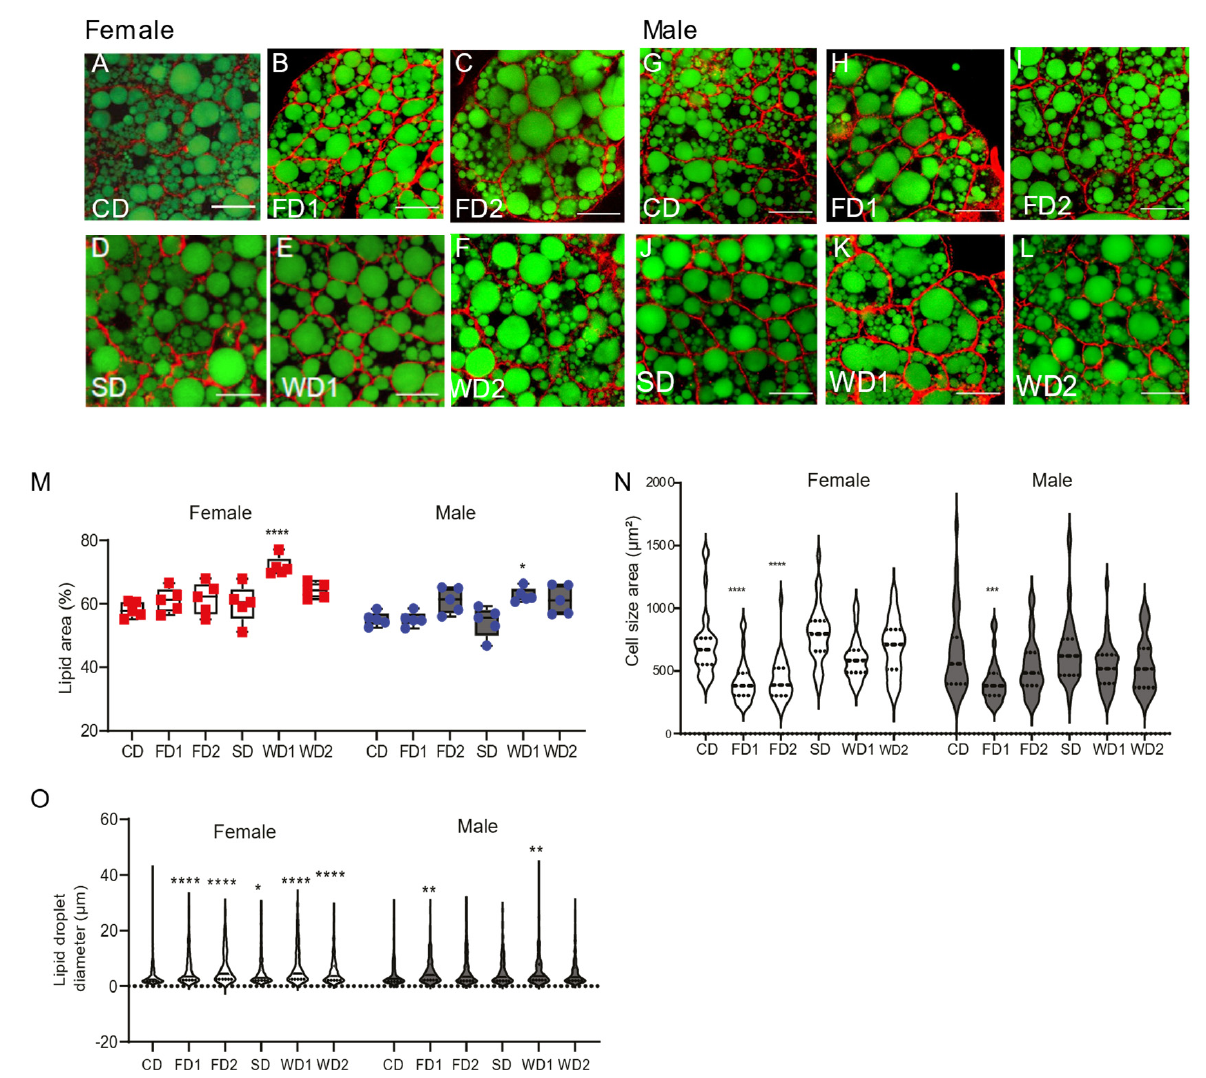
Figure 2. Changes in lipid area, cell size, and lipid droplet diameter in female and male flies on the diets supplemented with sugar, fat, or a combination of both. ( A – L ) Staining of lipid droplets with Bodipy (Green) and cytoskeleton with rhodamine phalloidin staining (red) on the abdomens of female ( A – F ) and male ( G – L ) Dahomey flies exposed to the normal diet (CD), fat (coconut oil)-supplemented diet (FD1 and FD2), (sucrose) sugar-supplemented diet (SD), and western diets (WD1 and WD2). Scale bars represent 20 µ m. ( M ) Quantification of the percentage lipid area relative to the cell area. The percentage lipid area was increased on western diets in both females and males. Data are shown as boxplots displaying the median, minimum, and maximum values. p -values were determined using two-way ANOVA. Main effects: diet, p < 0.0001; sex, p < 0.0001 and their interaction; ns, Dunnett’s multiple comparisons test comparing the data on the diets to those on the CD per sex. *** p < 0.0005, **** p < 0.0001. ( N ) Quantification of the cell size of fat bodies in females and males exposed to different diets. Data are shown as violin plots displaying the median and quartiles. p -values were determined using two-way ANOVA. Main effects: diet, p < 0.0001; sex, p = 0.03 and their interaction; p = 0.048 with Dunnett’s multiple comparisons test comparing the data on the diets to those on the CD per sex. *** p < 0.0005, **** p < 0.0001. ( O ) Quantification of the lipid droplet diameters in females and males exposed to different diets. Data are shown as violin plots displaying the median and quartiles. The two-way ANOVA main effects are: diet, p < 0.0001; sex, ns and their interaction; p < 0.0001 with a Dunnett’s multiple comparisons test comparing the data on the diets to those on the CD per sex. * p < 0.05, ** p < 0.005, *** p < 0.0005, **** p <